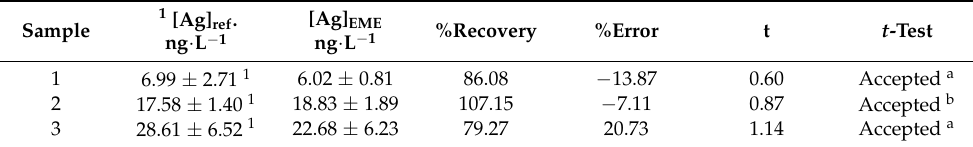
Table 4. Application of EME system to the analysis of silver in seawater samples.